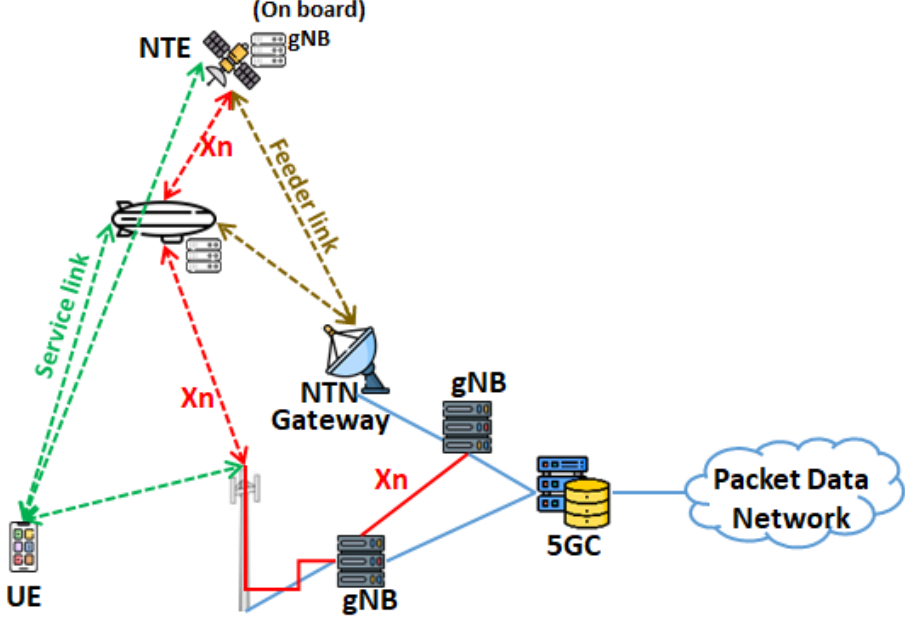
Figure 11. Typical dual connectivity architecture, involving one TN and one NTN or two